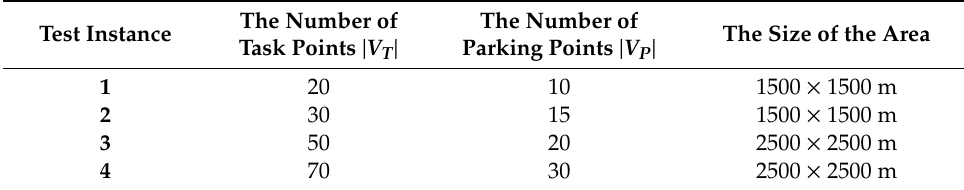
Table 3. Test instances with di ff erent Table 2. The objective function values of the different algorithms.